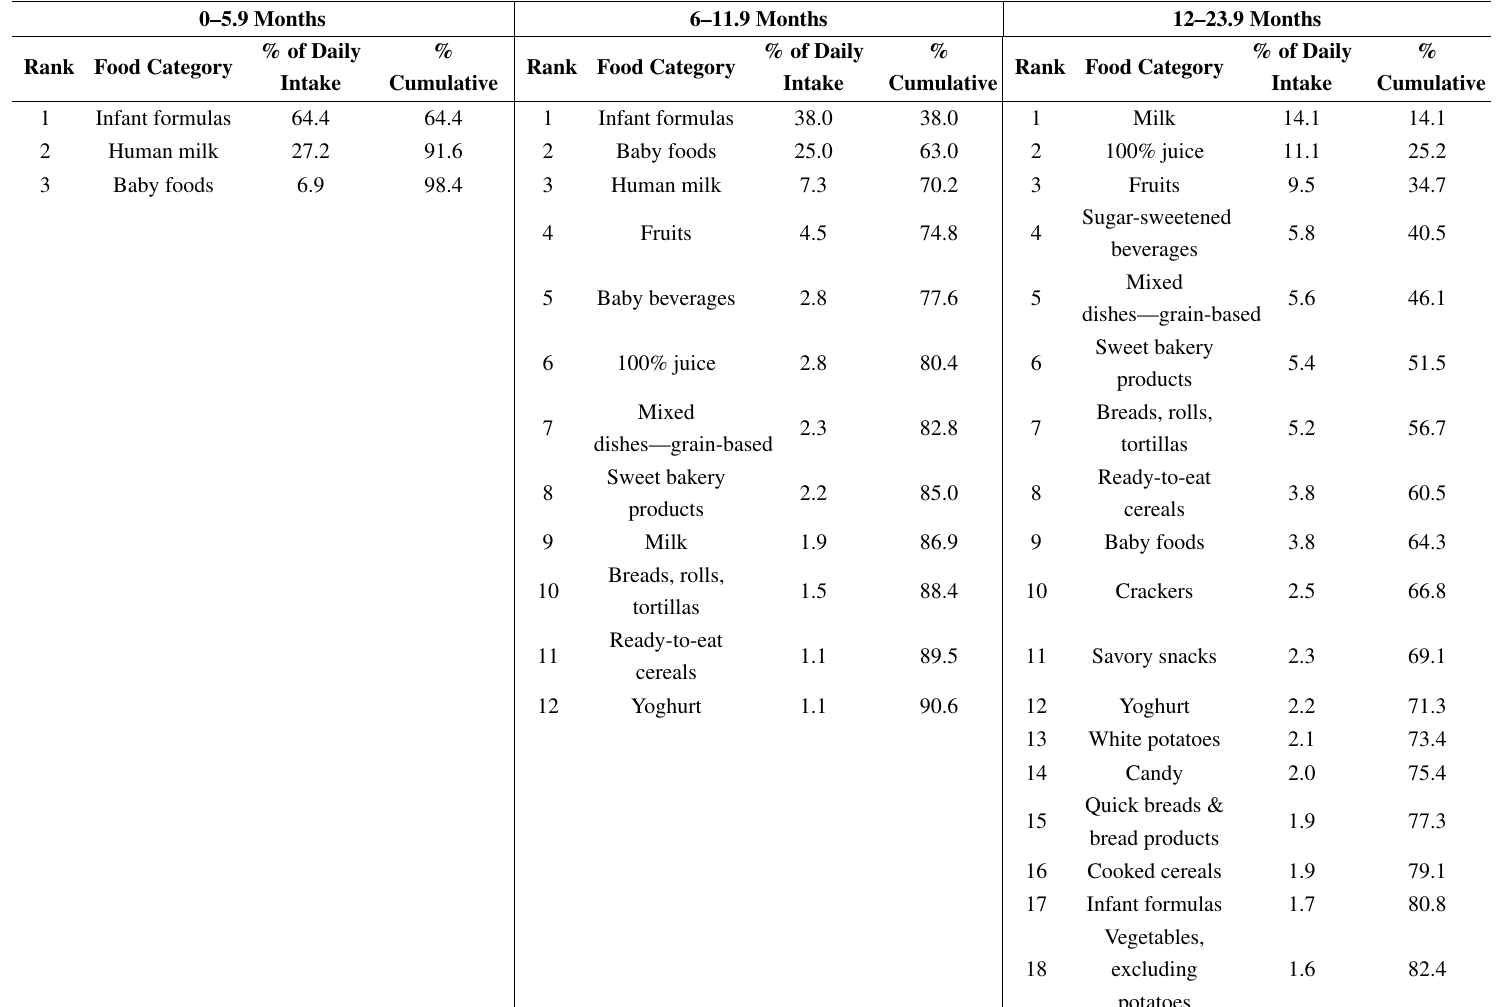
Table 6. Food sources of total carbohydrate among US infants and toddlers aged 0–23.9 months by age group: NHANES 2005–2012 ( n = 2740) a